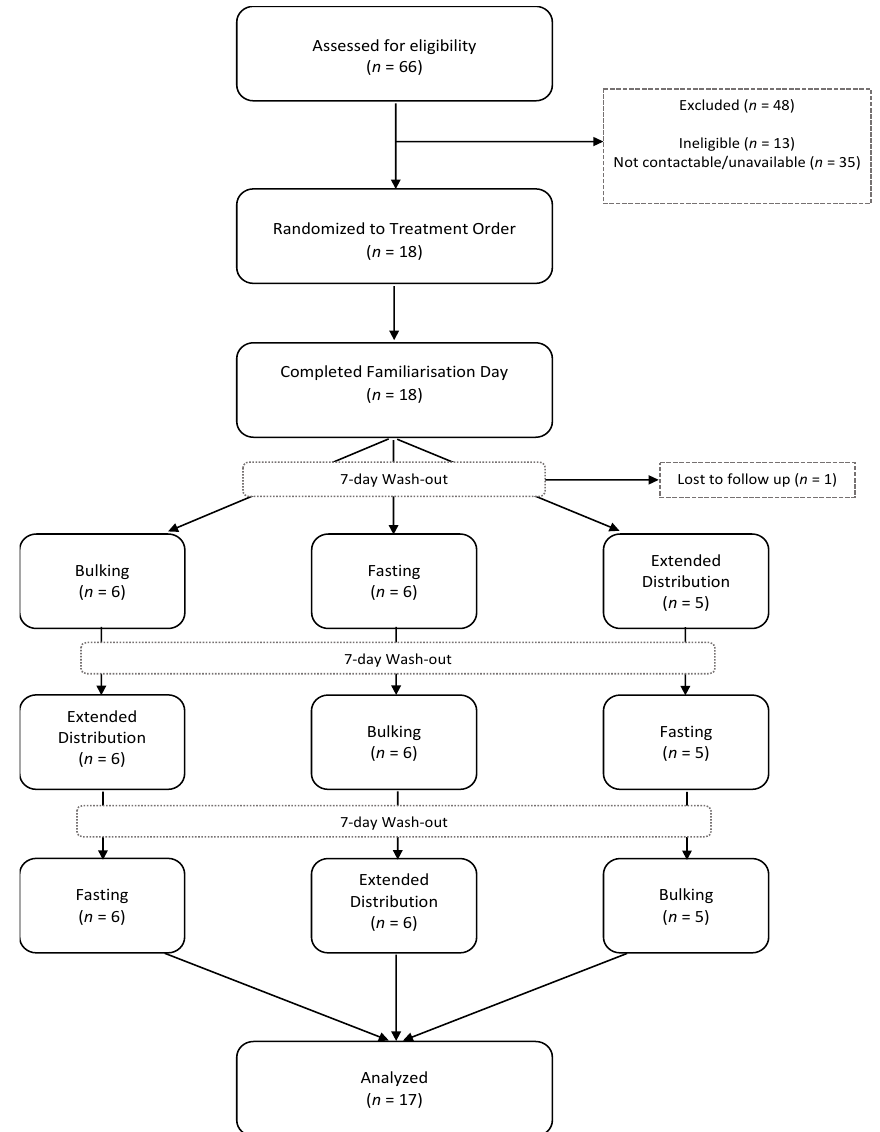
Figure 1. Participant flow through study.